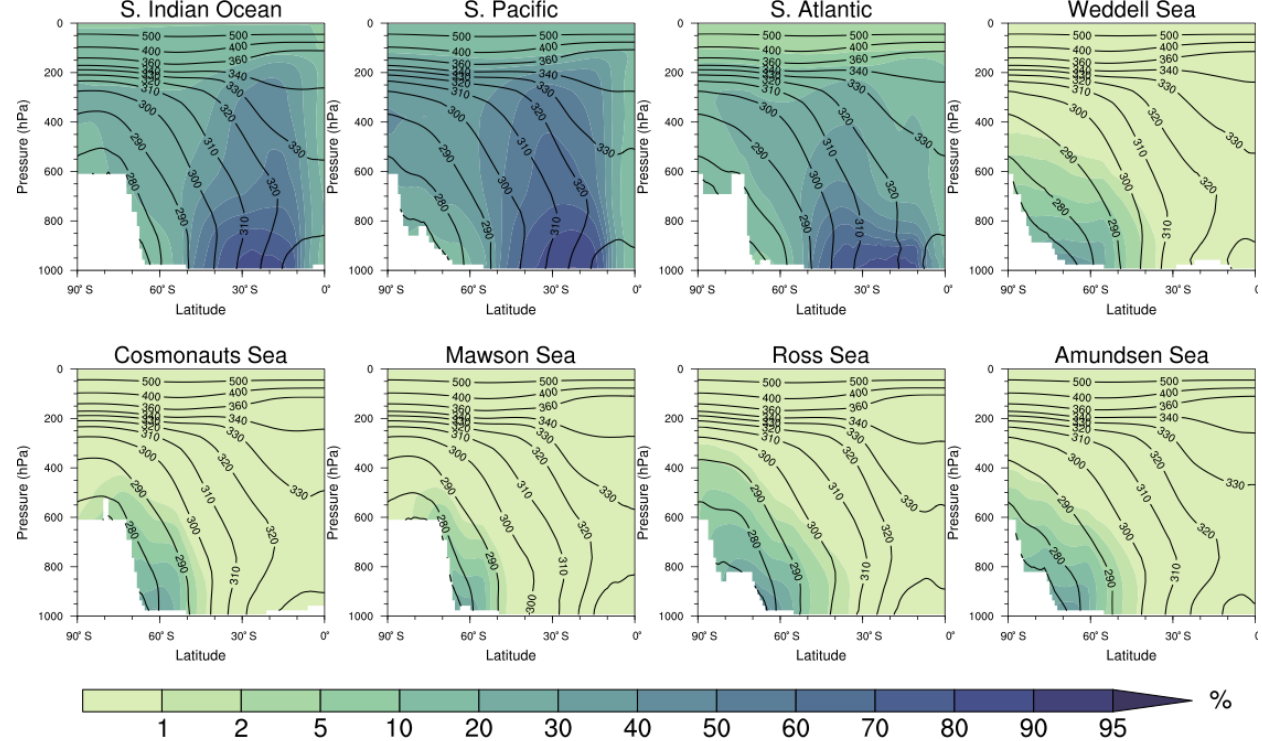
Figure 8. Vertical distribution of fractional contribution (%) to annual and zonal mean water vapor mixing ratio from individual source regions in the mean case. Contour lines are zonal mean equivalent potential temperature ( θ e ). Zonal mean in each panel is taken along the corresponding longitude band of the source